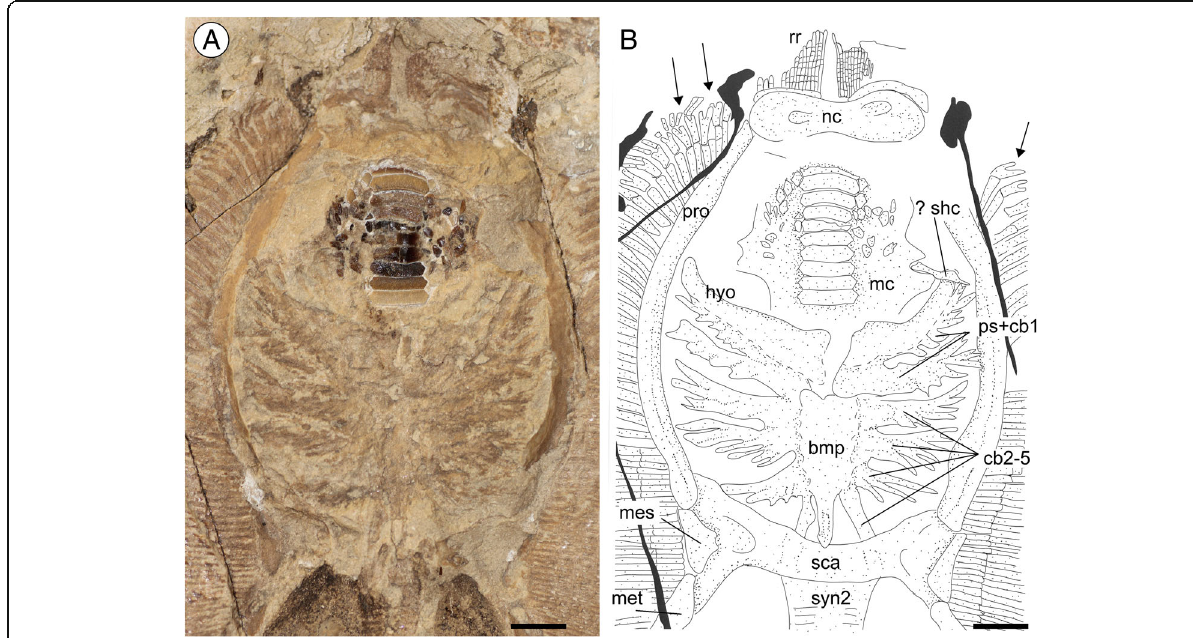
Fig. 3 Promyliobatis gazolai from the Eocene of the Bolca Lagerstätte. a Detail of the head region of the holotype MCSNV VII.B.90/91. b Reconstruction. Scale bars = 10 mm. Abbreviations: bmp, basibranchial medial plate; cb, ceratobranchials; hyo, hyomandibula; mc, Meckel ’ s cartilage; mes, mesopterygium; met, metapterygium; nc, nasal capsules; pro, propterygium; ps, pseudohyoid; rr, rostral radials; sca, scapulocoracoid; shc, secondary hyomandibular cartilage; syn2, thoracolumbar synarcual. The arrows indicate the anterior-most propterygial radials, which are branched and do not present interradial joints, therefore excluding the presence of the compagibus